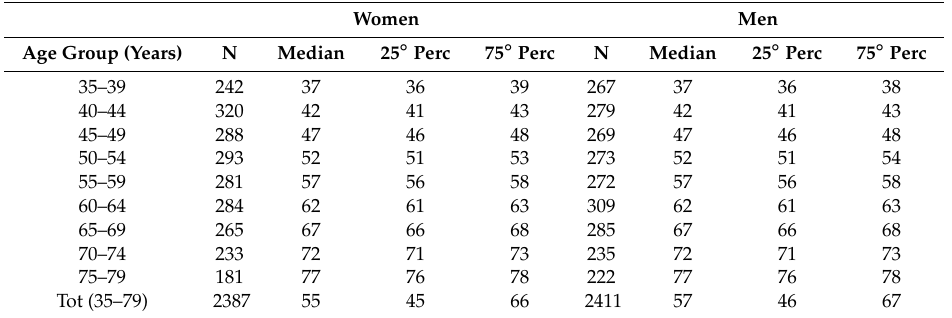
Table A1. Di ff erence between men and women in age distribution (data source: the CUORE Project Health Examination Survey 2008–2012, Italian men and women, 35–79 years old).